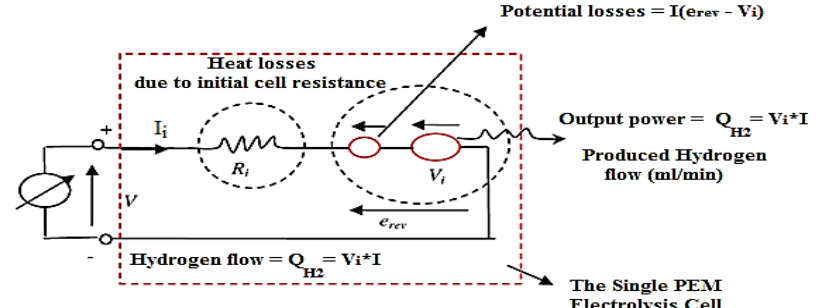
Figure 6. Equivalent electrical model for a single-cell PEM electrolysis.